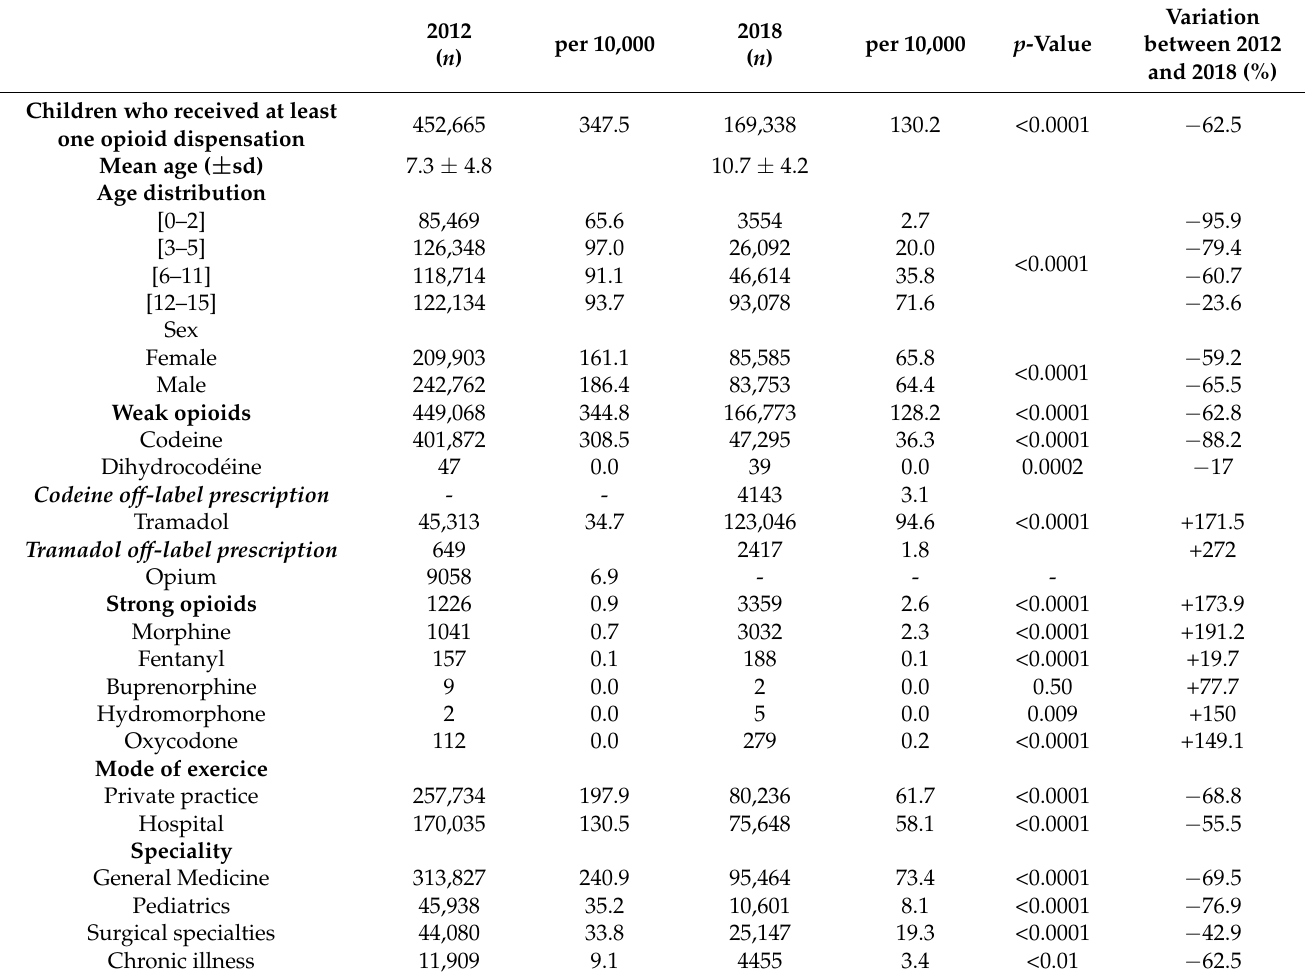
Table 1. Characteristics of children who received at least one opioid: comparison between 2012 and